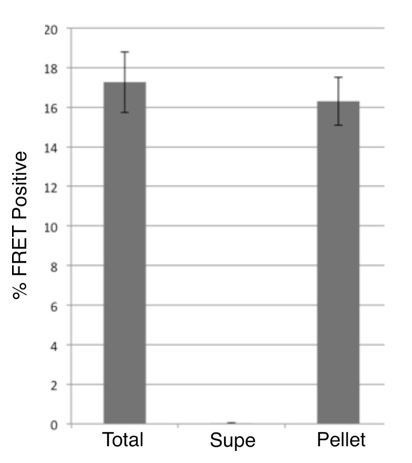
Immunoprecipitation of seeding activity from DS10.2.Lysates from DS10.2 cells expressing tau RD-YFP in an aggregated form were exposed to HJ9.3 antibody, which recognizes tau aa306-321, followed by immunoprecipitation. Total, supernatant, and pellet fractions were transduced via Lipofectamine into tau RD-CFP/YFP FRET biosensor cells, and the percentage of cells with aggregates was quantified by flow cytometry. After exposure to anti-tau antibody, no seeding activity remained in the supernatant, and all had been removed to the pellet fraction.